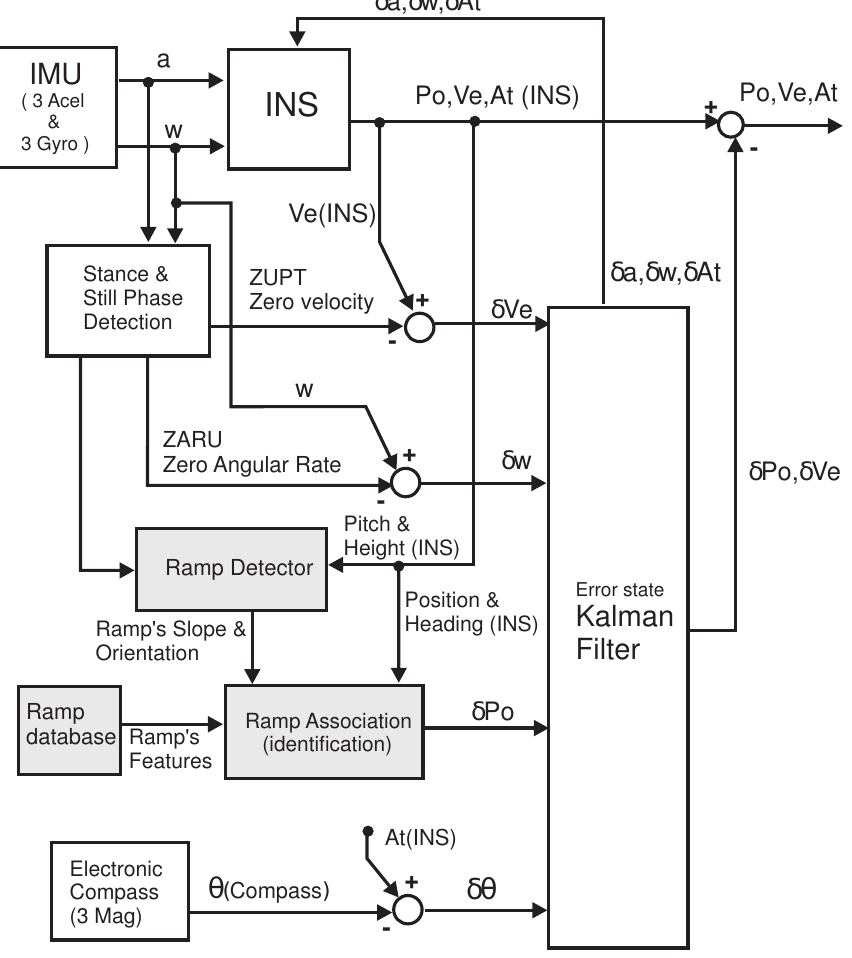
Figure 2. Block diagram of the PDR method with corrections based on ramps’